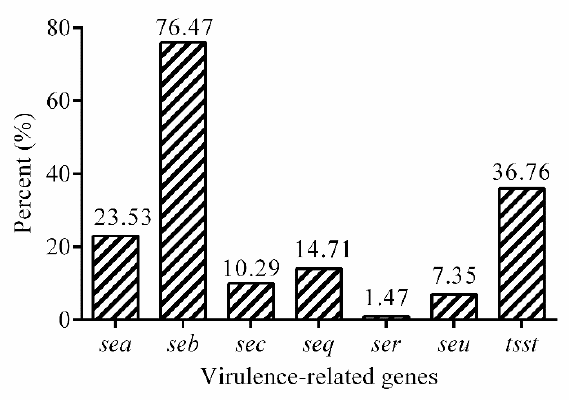
Figure 3. The prevalence of virulence genes in 68 isolates.